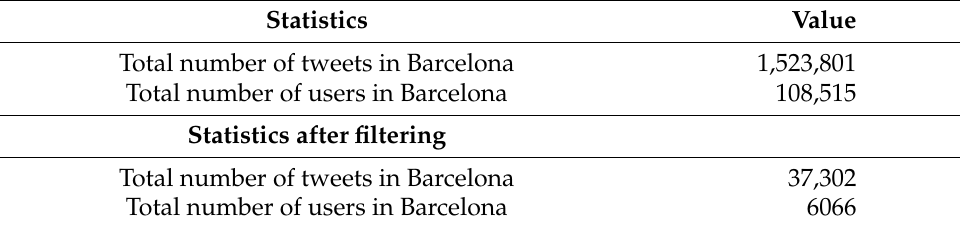
Table 1. Dataset